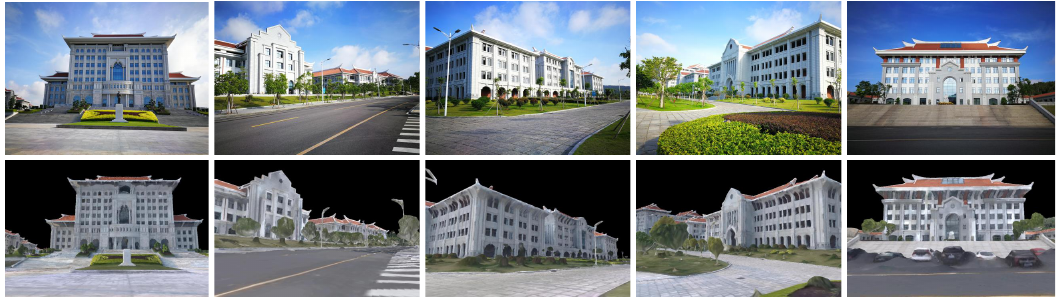
Figure 6. The corresponding image pairs of ground camera images and rendered images. Top: Ground camera images; Bottom: Rendered